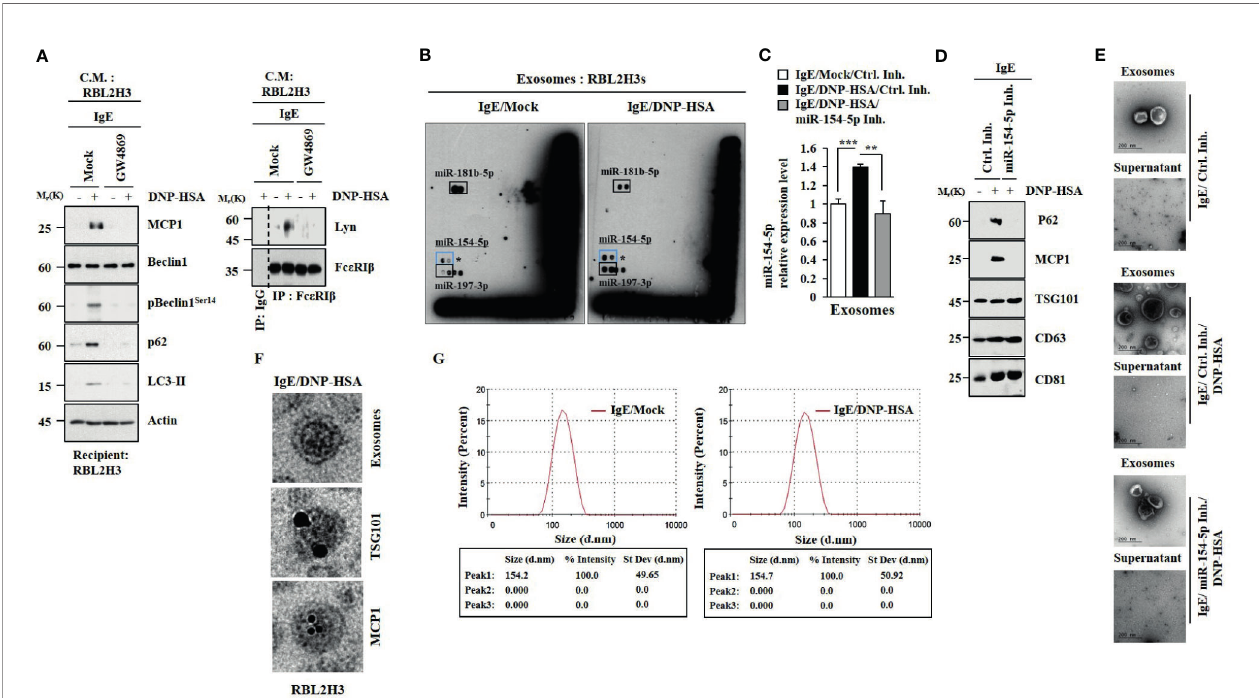
FIGURE 6 | MiR-154-5p and MCP1 are present in exosomes. (A) IgE-sensitized RBL2H3 cells were pretreated with GW4869 (10 uM) for 24 h followed by stimulation with DNP-HSA for 1 h. The culture medium was then added to RBL2H3 cells for 24 h. Representative blots of three independent experiments are shown. (B) IgE-sensitized RBL2H3 cells were stimulated with DNP-HSA for 1 h. Exosomes were then isolated and subjected to miRNA array analysis. (C) QRT-PCR was performed. ** p <0.01; *** p <0.001. Average values of three independent experiments are shown. (D) Immunoblot was performed. Representative blots of three independent experiments are shown. (E) Exosomes were seen by negative staining electron microscopy. (F) General appearances of isolated exosomes and immuno-gold staining images using anti-TSG101 and anti-MCP1 antibodies. Twenty- fi ve and 10 nm gold particles indicate localizations of TSG 101 and MCP1, respectively. (G) Size distribution of RBL2H3-derived exosomes was determined with a Zeta sizer